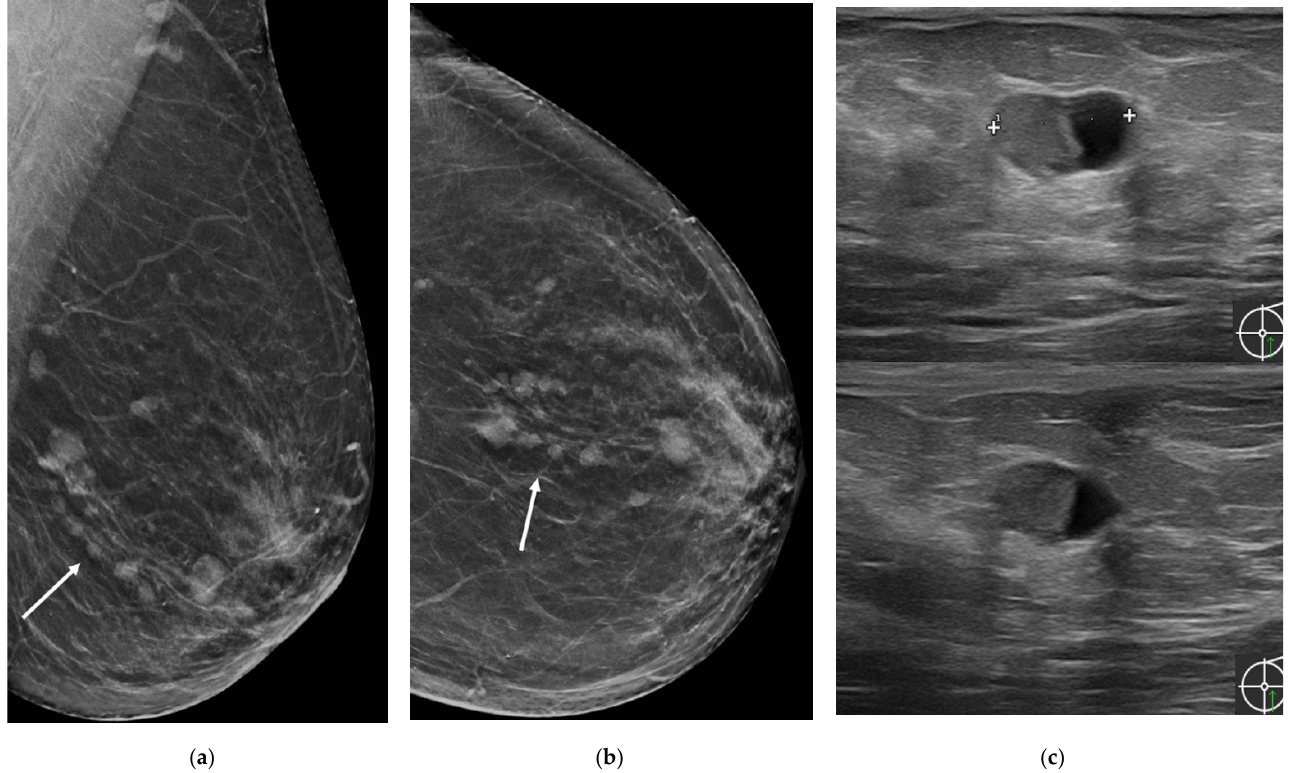
Figure 2. A 55-year-old asymptomatic woman. ( a ) Medio-lateral view and ( b ) cranio-caudal view of screening mammography demonstrated small round or oval opacities in the lower-outer quadrant of the left breast (arrows); ( c ) Ultrasound examination showed multiple intracystic masses.